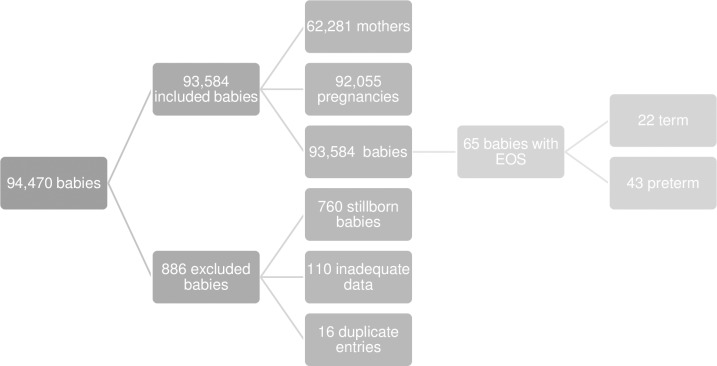
Inclusions and exclusions.